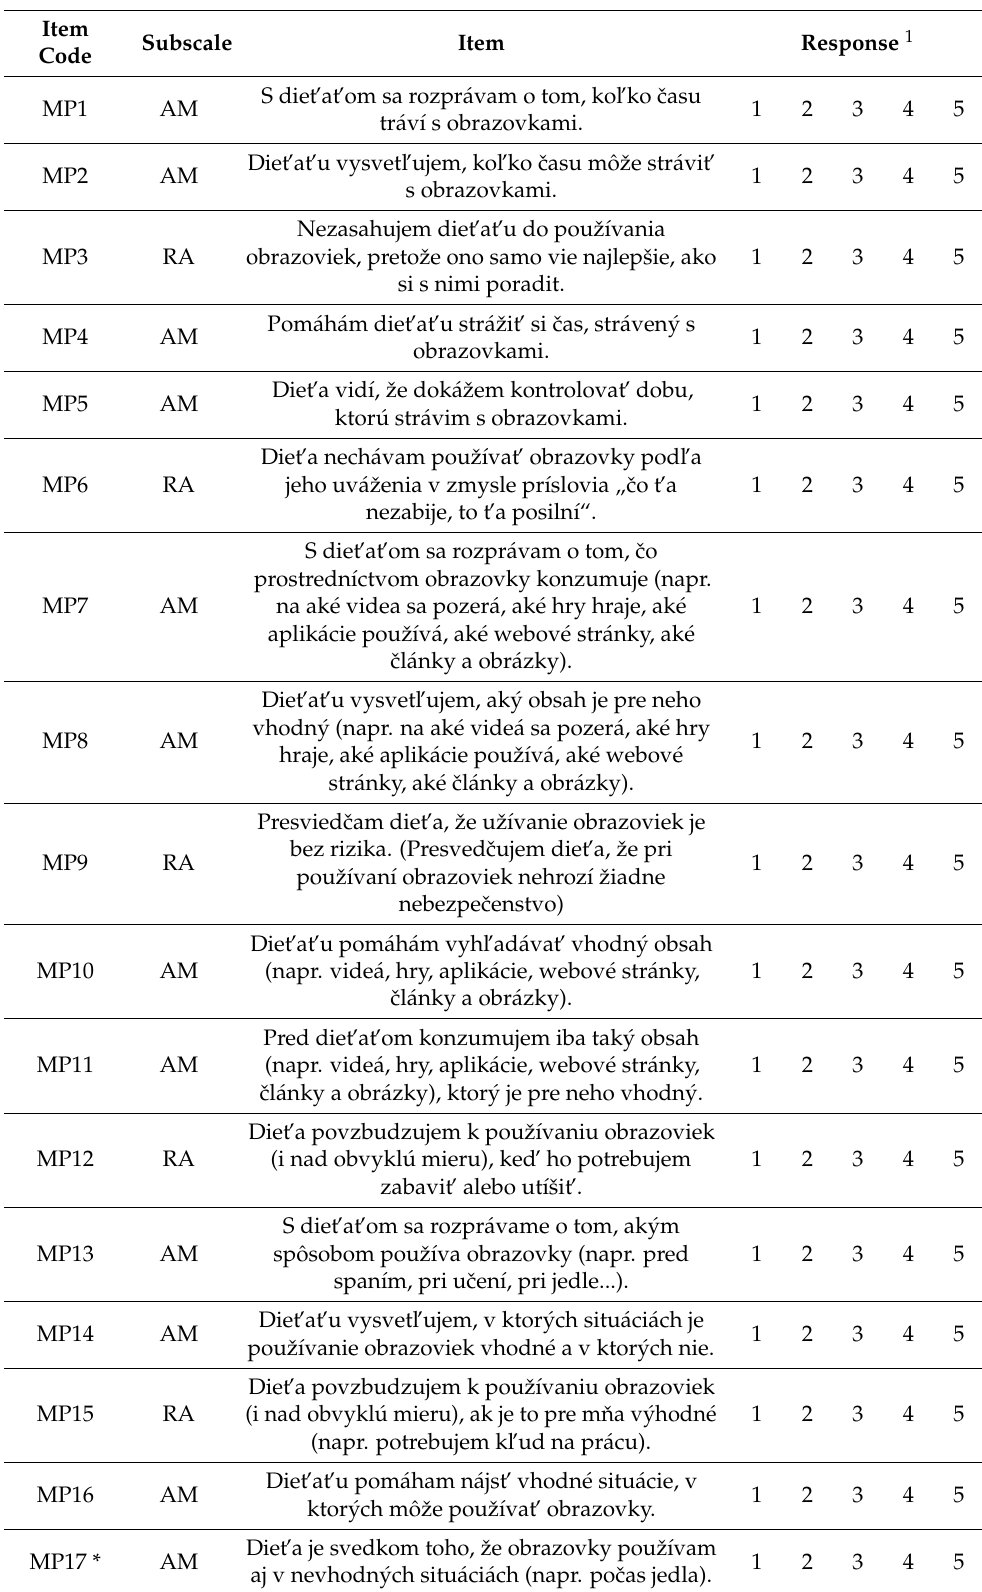
Table A3. MEPA-36: Slovak